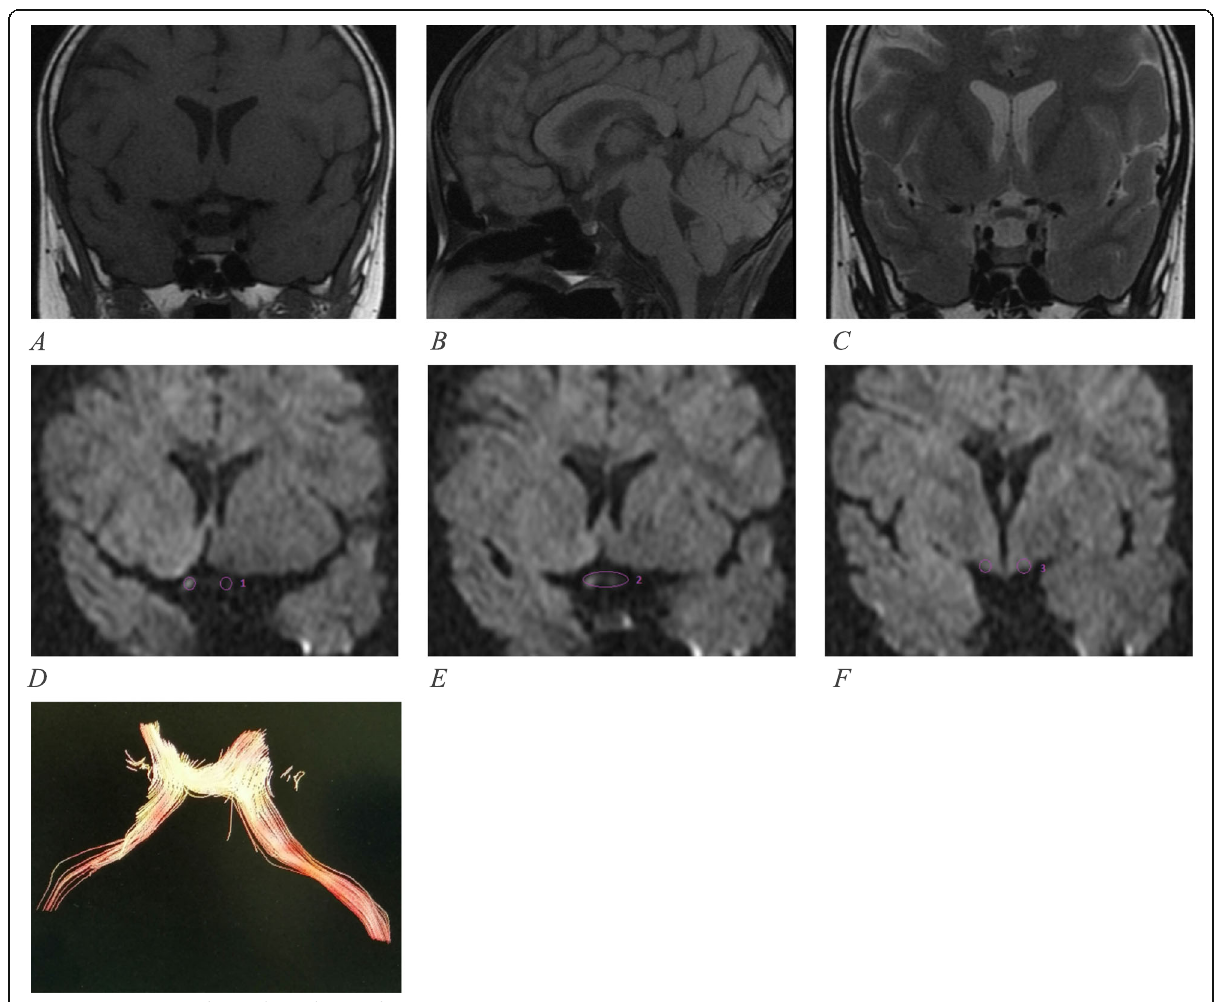
Fig. 4 A control case of 21-year-old female patient presented with headache showing normal MRI study of sella. MRI of the sella coronal T1 ( a ) and sagittal T1 ( b ), coronal T2 ( c ), and DTI of the optic pathway were done and ROI delineation on DTI maps. Color ROI are drawn on anterior optic tracts ( d ), the optic chiasm ( e ), and the posterior optic tracts ( f ) showing that the pituitary gland is contained within the sella with concave upper border. No evidence of pituitary focal lesions and normal appearance of suprasellar cistern. DTI examination shows the following: FA = 0.089, 0.26, 0.192; ADC = 2.89, 2.03, 1.98 μ m 2 /ms; AD = 2.4, 2.5, 2.6 μ m 2 /ms; and RD = 1.6, 1.4, 1.8 μ m 2 /ms of the anterior optic tracts, the optic chiasm, and the posterior optic tracts respectively